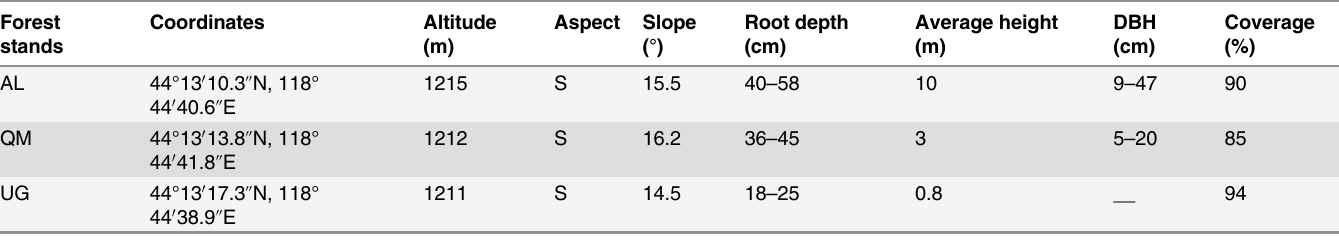
Table 2. Characteristics of vegetation types. Forest